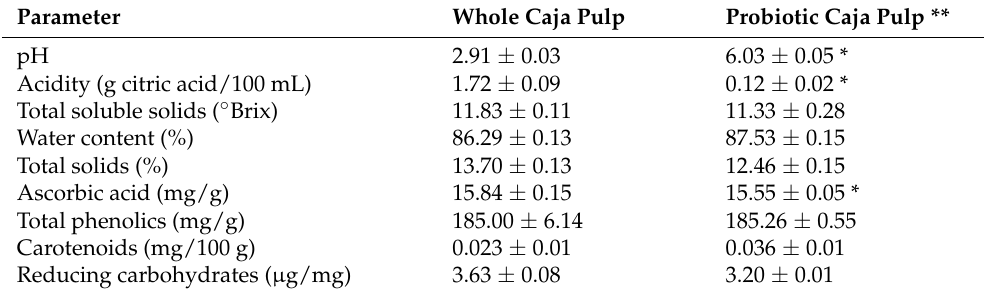
Table 2. Physicochemical characterization of the whole and probiotic caja pulp, fermented for 22